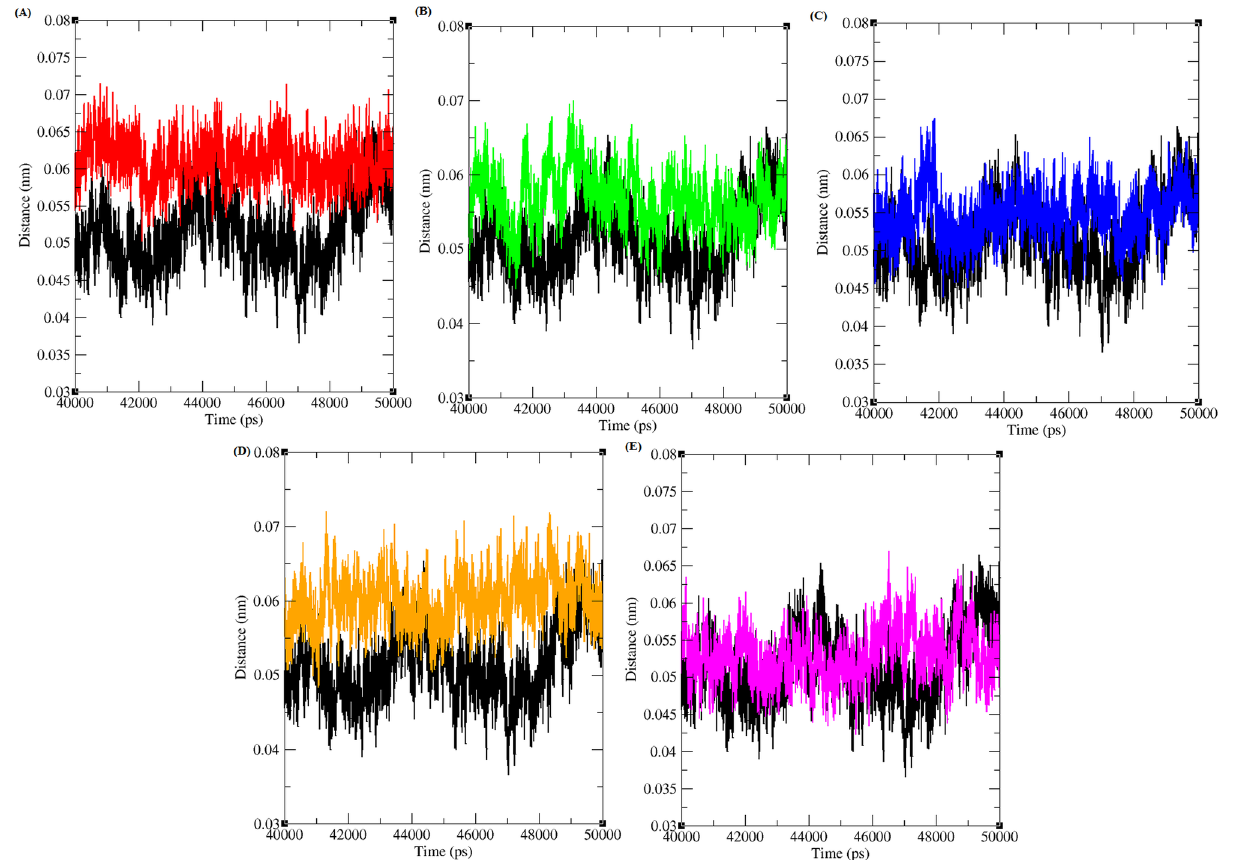
Fig 4. Minimum distance between CDK4 and cyclin D1 protein in native and mutant state. Black, Red, Green, Blue, Orange and Pink lines indicate native, R24C, Y180H, A205T, R210P and R246C protein complexes respectively.